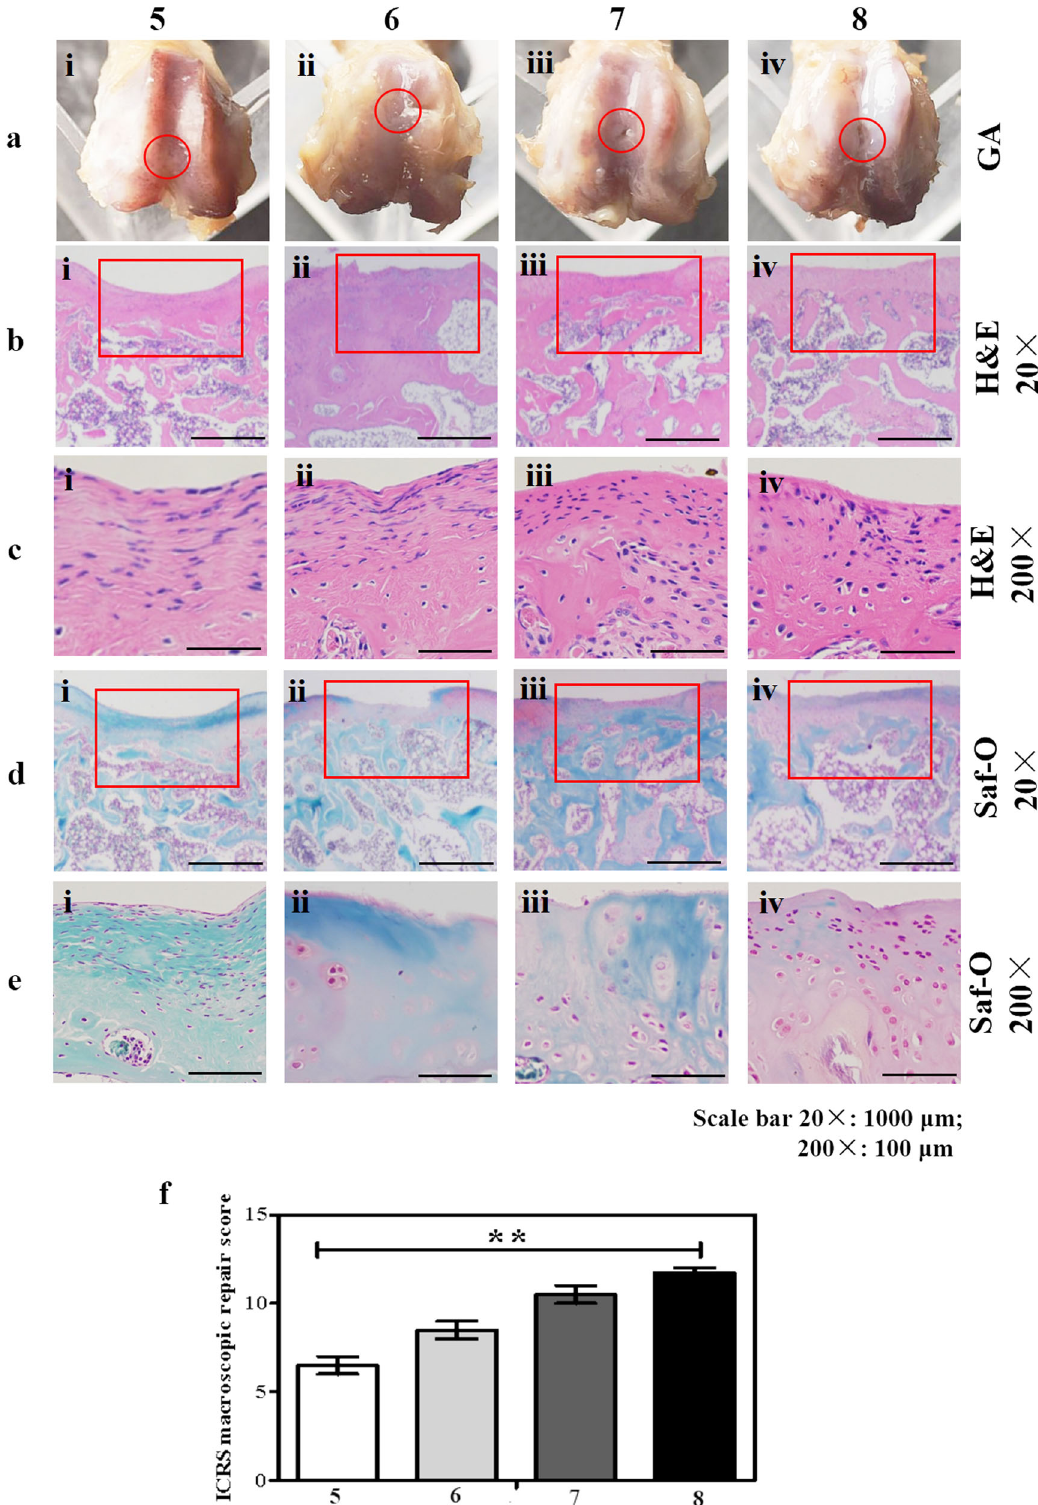
Fig. 6 Data from in vivo experiments. a (i – iv) photographs of the cartilage layer on the femoral part of the knee joint (site of implantation), taken directly after sacri fi ce and opening of the knee joint. b (i – iv) , c (i – iv) representative tissue slices, stained with H&E, See text. d (i – iv) , e (i – iv) representative tissue slices, stained with Safranin O, See text. Red frames indicates the cartilage defect. f (i – iv) the ICRS macroscopic repair scores were quanti fi ed. (Error bars: ±SD, * p < 0.05, ** p < 0.01, *** p < 0.001). Scale bar = 1000 μ m (20×), Scale bar = 100 μ m